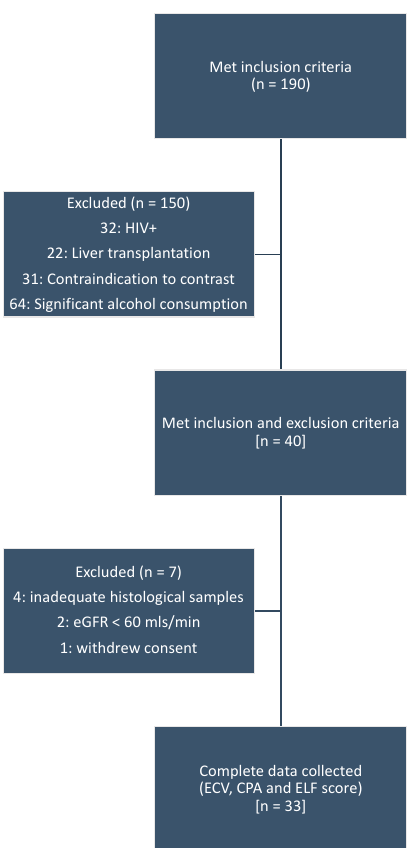
Figure 1. Flow diagram of participants through the original study, from which the datasets were used for re-analysis in this study.